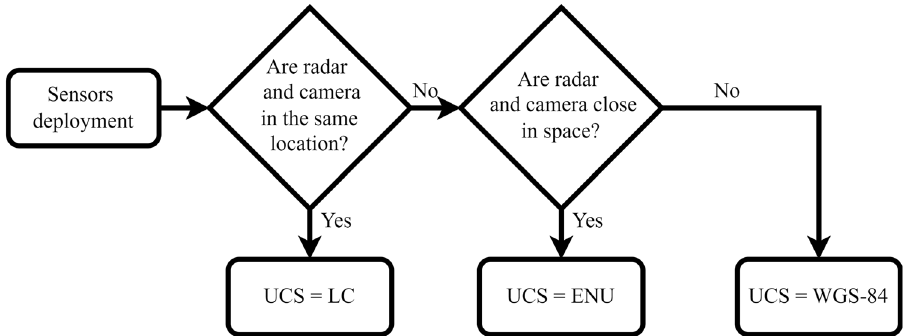
Figure 4. UCS selection in three sensor deployment